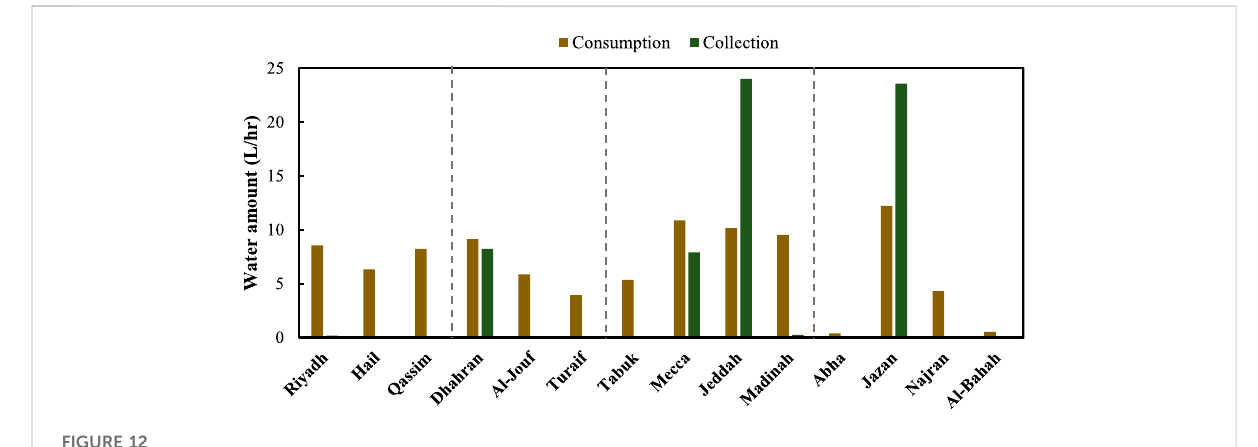
FIGURE 12 Annual water consumption and collection in different cities.